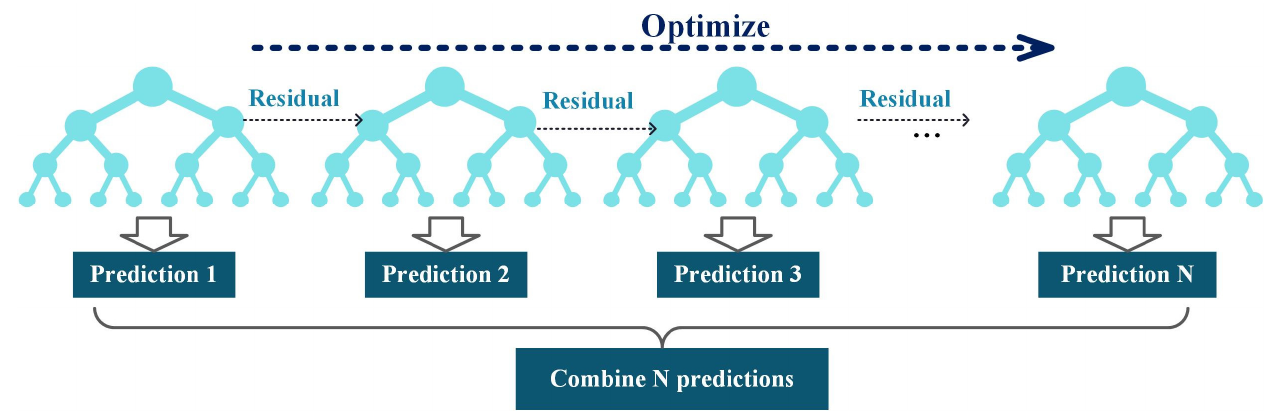
Figure 2. Schematic diagram to build the GBT model.